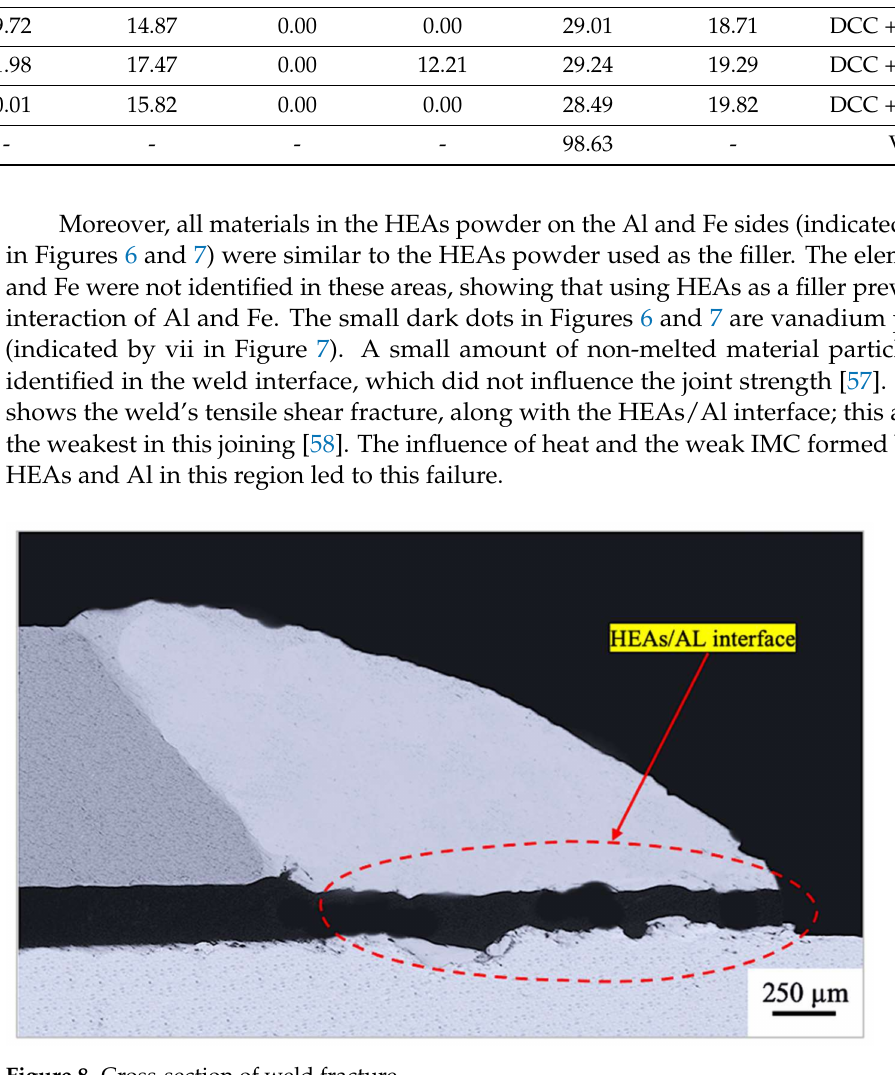
Figure 8. Cross-section of weld